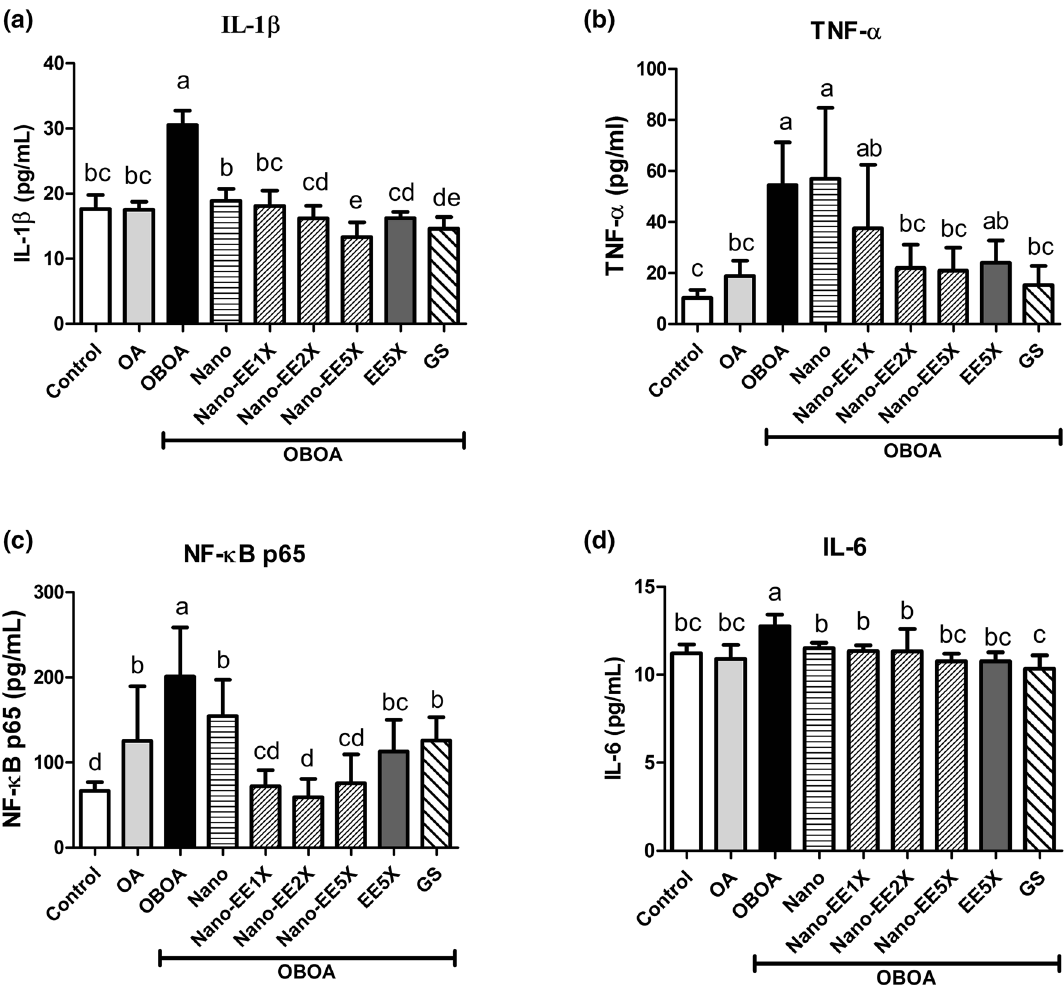
Figure 5. Plasma ( a ) IL-1β, ( b ) TNF-α, ( c ) NF-κB p65, and ( d ) IL-6 level in osteoarthritis rats fed different doses of Nano-EE and EE after 6 weeks. Data are shown as the mean ± SD (n = 6 rats/group). The levels of IL-1β, TNF-α, NF-κB p65, and IL-6 were analyzed by ELISA kits. The values with different letters (a–e) represent significantly different (p < 0.05) as analyzed by Duncan’s multiple range Histology staining (Safranin O) on the knees of OArats fed with different doses of Nano‑EE and EE. It was under- stood that OA caused the loss of proteoglycan and the presence of uneven cartilage surface under the Safranin O tissue staining section. After the slice images were taken through the microscope, it was found that the con- trol group had an obvious accumulation of proteoglycan and the cartilage surface was flat. In OA and OBOA groups, the loss of proteoglycans and the unevenness of the cartilage surface were found. In the Nano group, there were no improvements in the loss of proteoglycan, and the surface of the cartilage of Nano-EE1X and Nano-EE2X was still observed with some unevenness and proteoglycan loss. Compared with the OBOA group, the Nano-EE5X dosage had significantly improved the loss of proteoglycan and improved the unevenness of the cartilage surface. EE5X and positive control group also improved the proteoglycan loss. The results showed that Nano-EE can effectively improve the cartilage proteoglycan loss and make the cartilage surface flat (Fig. 7b). The OARSI score of cartilage tissues was given in Fig. 7c. The OARSI score was conducted according to Pritzker et al. 32 . Healthy cartilage tissues were observed in the control group followed by Nano-EEX. Healthy tissue is characterized by a smooth cartilage layer and chondrocytes were present in well-ordered zones. The tissues of Nano-EE2X, EE5X, and GS were lying between grades 1 and 2. Superficial zone intact, oedema, and cell death were observed in grade 1 tissues. The score of Nano and Nano-EE1X were observed between 2 and 3. Surface discontinuity and vertical fissures were common in grade 2 and 3 tissues. High-grade OA histopathology was observed in the OBOA group followed by the OA group. These groups were characterized by cartilage matrix loss and denudation 27,32 .